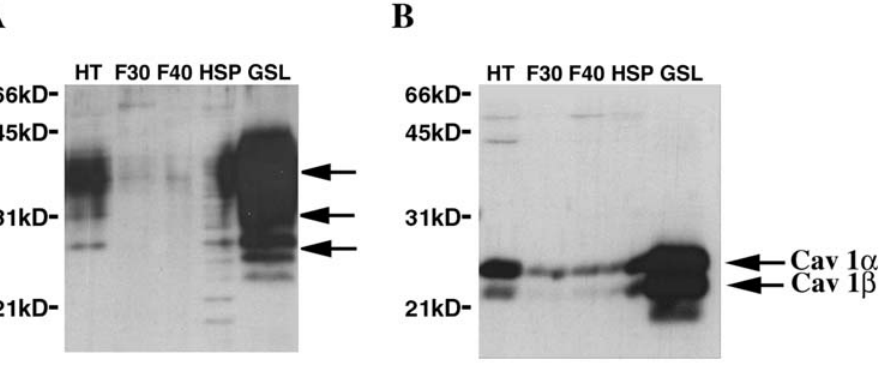
Figure 1. PrP C partitions in lipid rafts of 1C11 cells. Proteins (10 m g) from different fractions of 1C11 cells isolated on a discontinuous sucrose gradient, i.e. total homogenate (HT), the 30% (F30) and 40% (F40) soluble layers, insoluble pellet (HSP) and the raft (GSL) fraction, were separated on a 12% SDS-PAGE and analyzed by western blotting. The presence of PrP C (A) and caveolin 1 (B) was assessed using SAF32 and C060 monoclonal antibodies, respectively. Arrows indicate the different forms of PrP C (non-, mono and biglycosylated) and the a and b chains of caveolin 1.